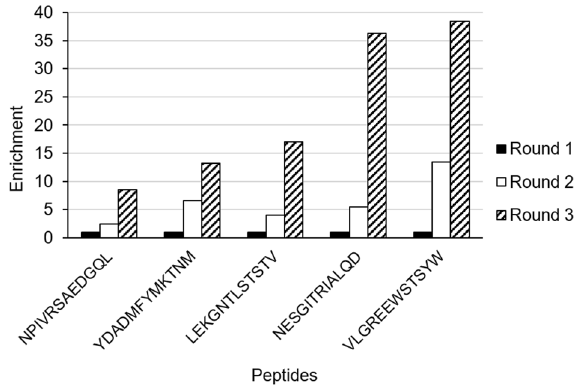
Figure 2. The top peptides enrichment in each round of biopanning. The Y-axis represents the enrichment and the X-axis represents the peptide sequences.